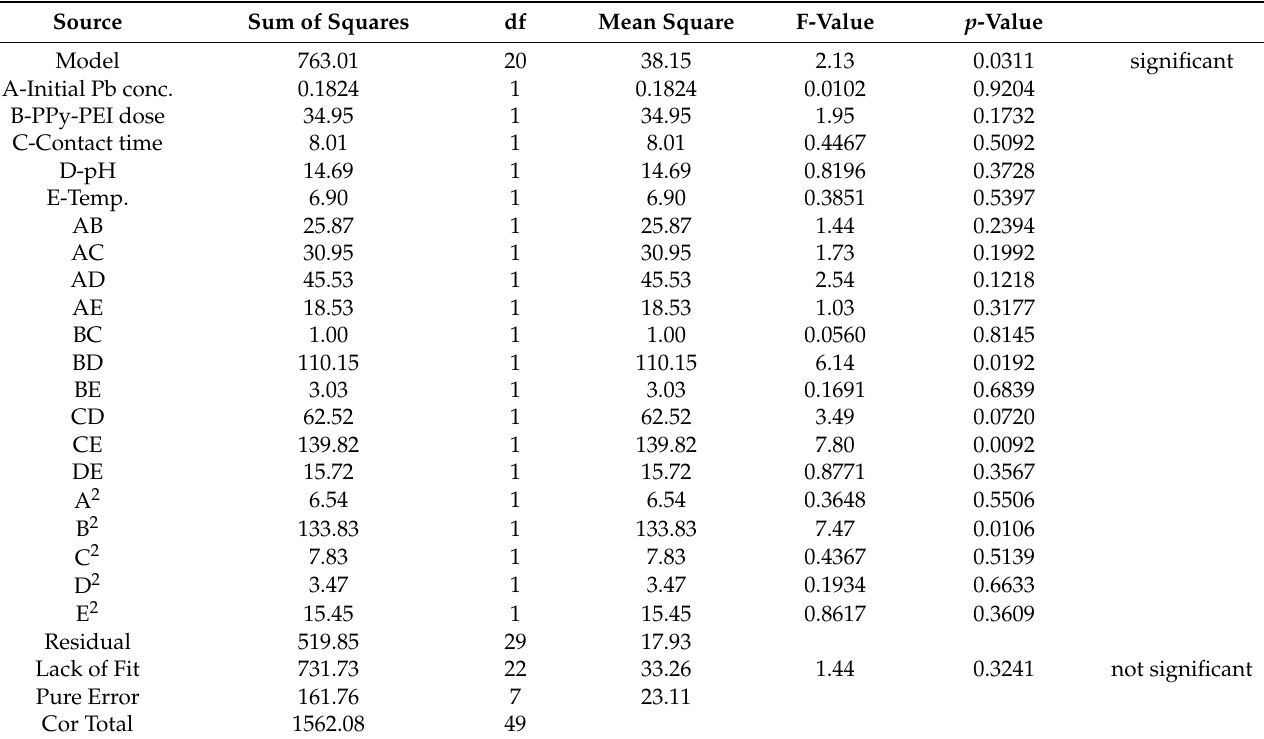
Table 3. Analysis of variance (ANOVA) by RSM for Pb 2+ removal